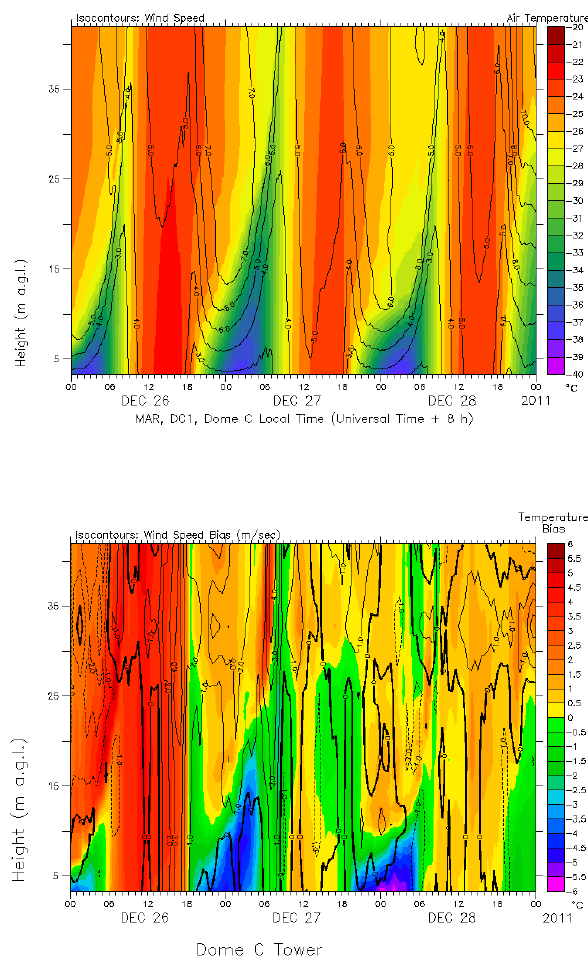
Figure 4. Temperature (colour) and wind speed (isocontours) at the Dome C tower, as a function of Local Time LT (Universal Time UT + 8h) and height above the surface. (a) refers to the MAR sim- ulation, (b) to simulation minus observation.